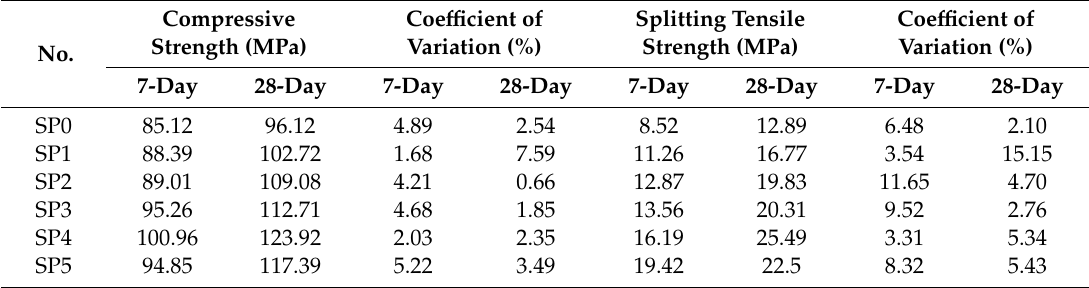
Table 10. Results of mechanical property test on hybrid polypropylene-steel fiber RPC.